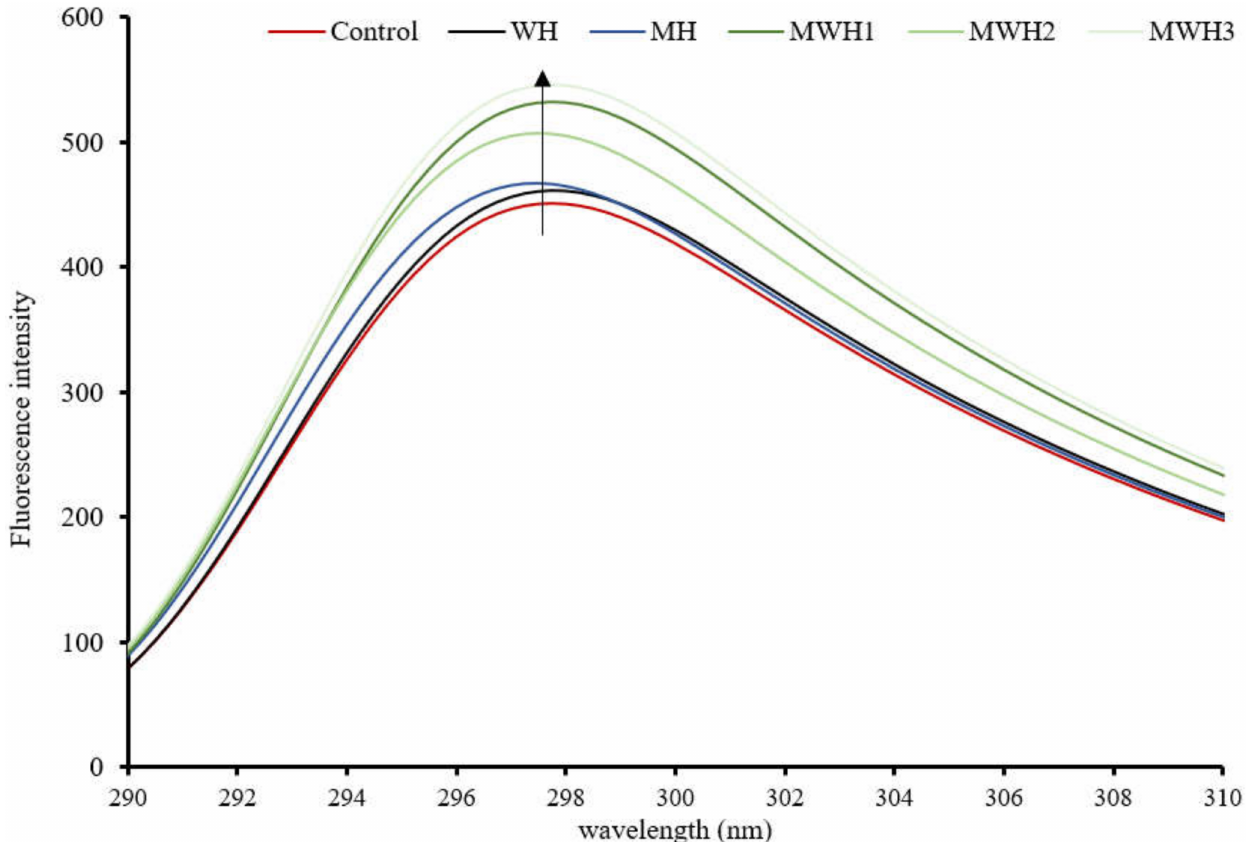
Figure 3. Tryptophan fluorescence spectra of SCM under different heating